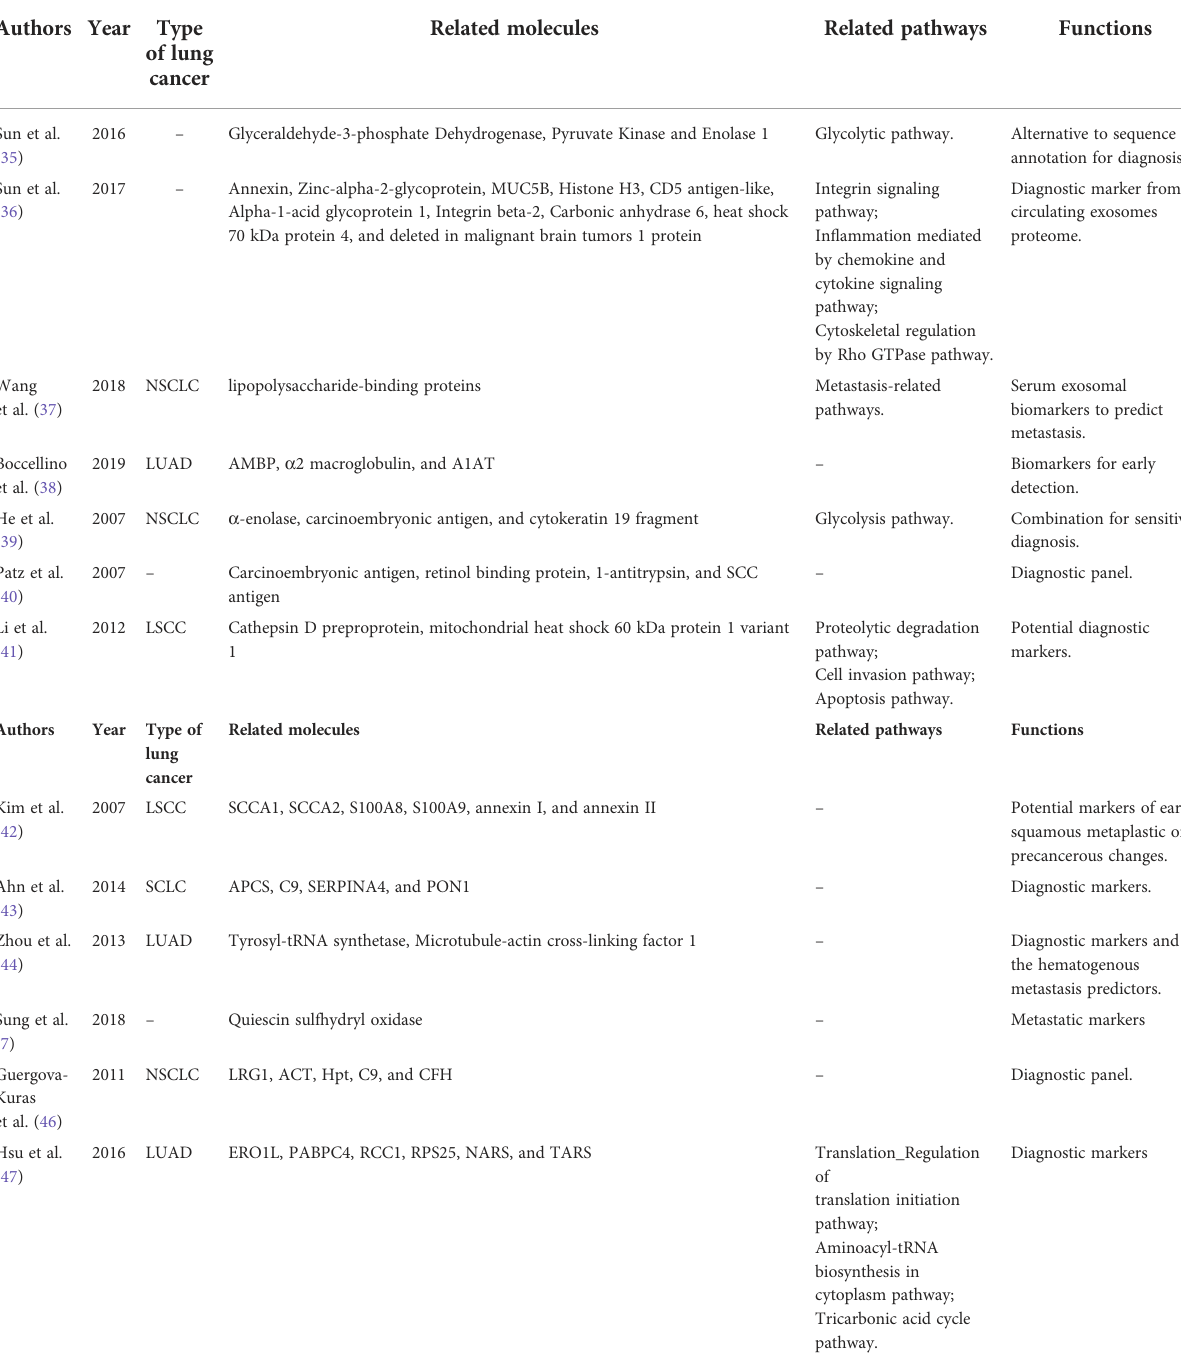
TABLE 2 Role in the diagnosis of lung